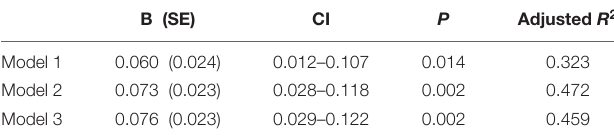
TABLE 6 | The results of multiple linear regression analyses assessing the associations between the serum copper level and MMSE in non-demented older adults with no decrease in food intake over the past 3 months ( n =